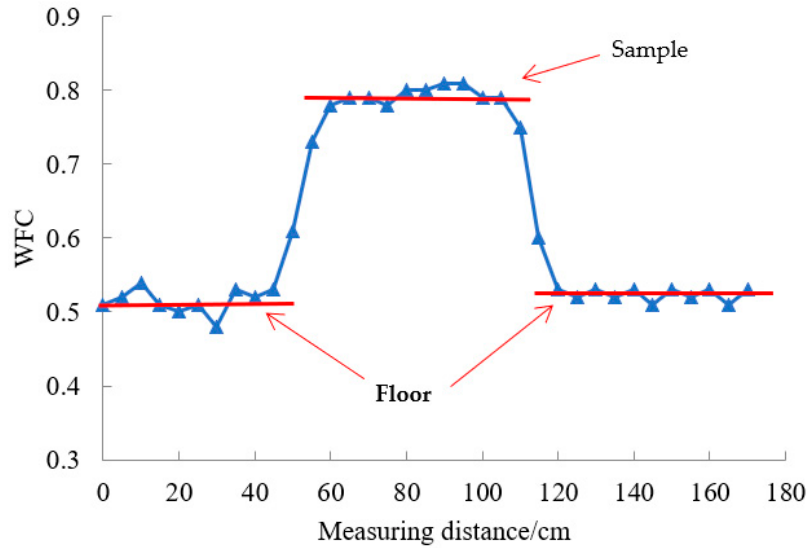
Figure 4. Sensitivity analysis of WFT to micro-texture.